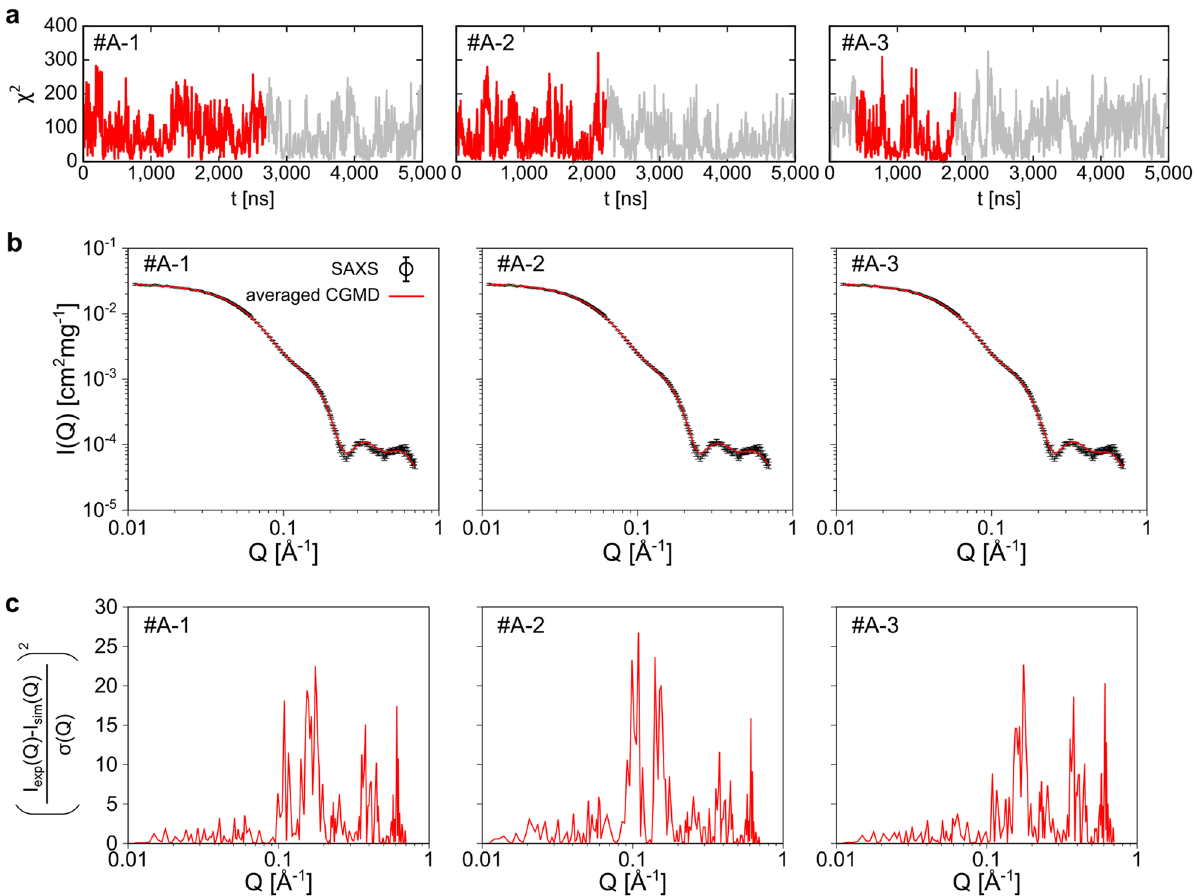
Figure 2. Extracting time series satisfying χ 2 < 3.0 from CGMD simulation trajectories by the SAS-CLIP. ( a ) Trajectories of χ 2 during CGMD simulations. The regions corresponding to the clipped time series #A-1, #A-2, and #A-3 are shown in red. The other regions are shown in gray. ( b ) Averaged SAXS profiles of the time series #A-1, #A-2 #A-3 (red lines) are compared with the experimental SAXS profile (black circle with error bars of s.d.). ( c ) The squared residuals of the averaged scattering intensities.